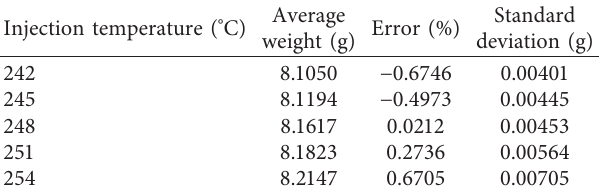
Table 2: Product weight under varying injection temperature. Injection temperature ( ° C)